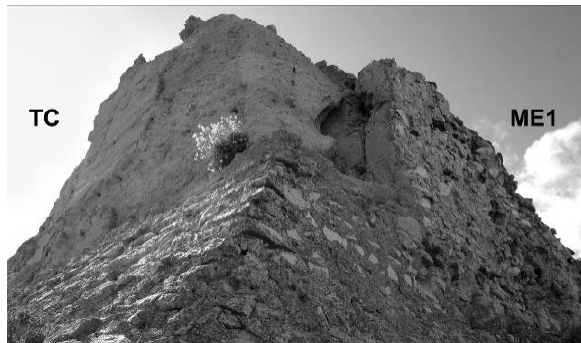
Figure 10. Tower A. North-eastern angle.